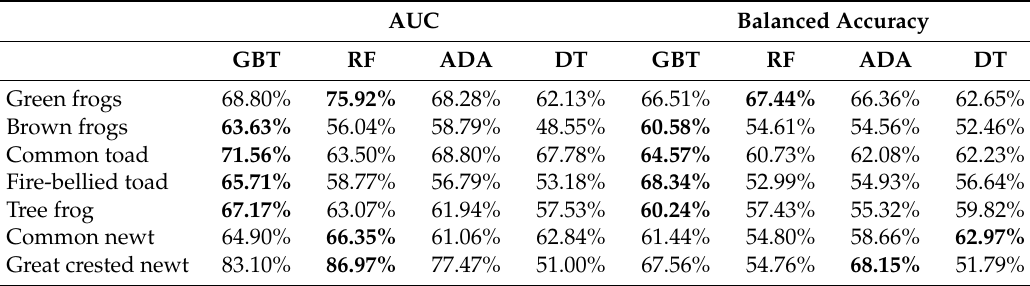
Table 2. The performances obtained for four evaluated classification models for each of the amphibian species. The values represent area under curve (AUC).